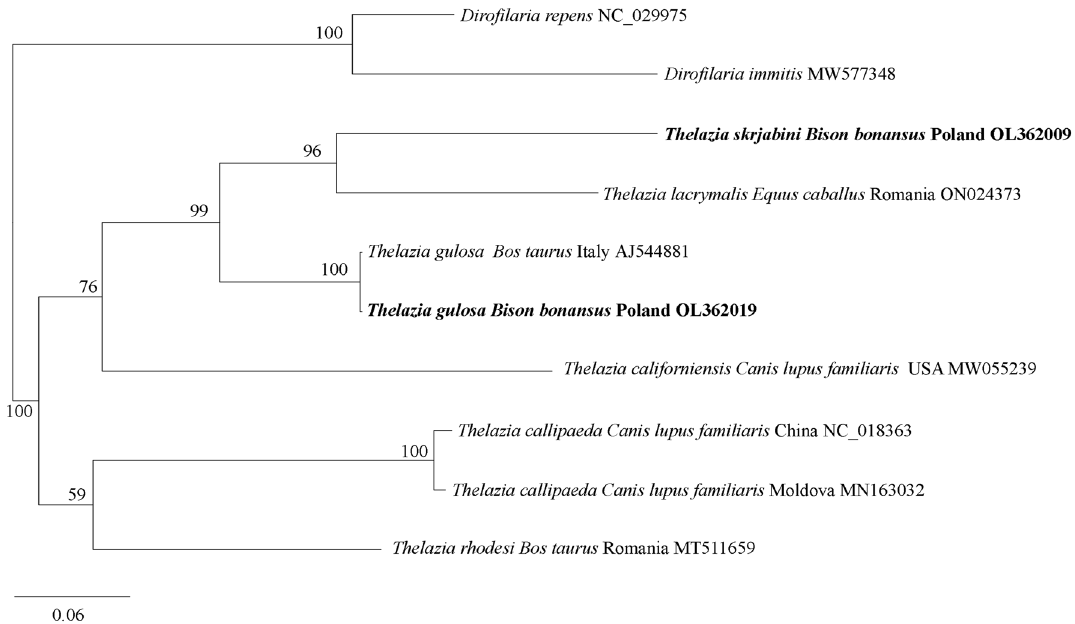
Figure 1. Phylogenetic tree of Thelazia spp. based on cox1 partial sequences, constructed by Bayesian inference (BI) analysis using MrBayes version 3.2. The GTR+I+G model was chosen as the best-fitting nucleotide substitution model using JModelTest version 2.1.10 software 45,46 . Analysis was run for 1,000,000 generations, with 250,000 generations discarded as ‘burn-in’. Nodal support is indicated as Bayesian posterior probabilities. Sequences of Dirofilaria repens and D. immitis were used as the outgroup. Sequences from this study are in bold. The scale bars are proportional to the number of substitutions per